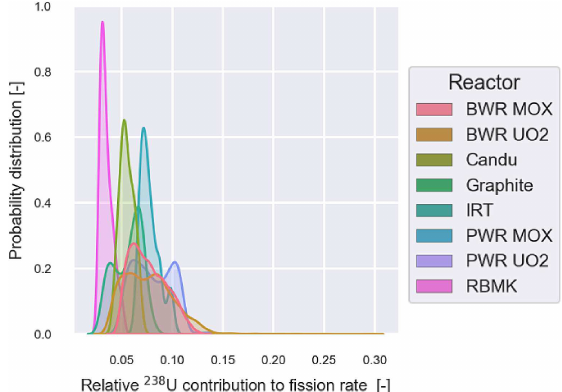
Fig. 3. Distribution of the 238 U relative contribution to fissions for all cases from the assessment database. A non-negligible amount of fissions originate from 238 U, as the low cross-section is somewhat balanced by the large 238 U content in low-enriched uranium